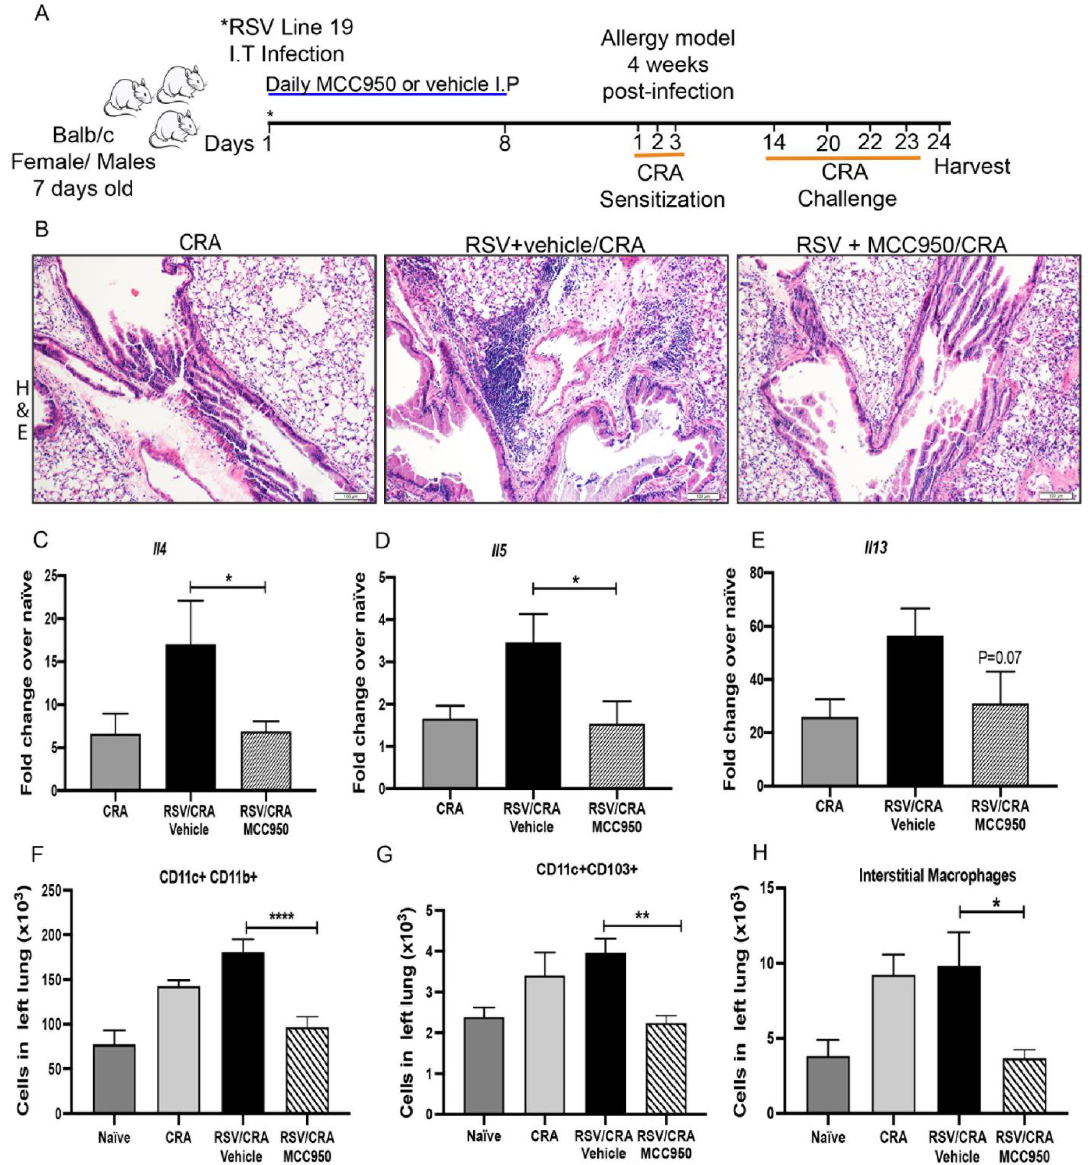
Figure 7. NLRP3-inflammasome inhibition during early-life RSV infection attenuated secondary allergic exacerbation. ( A ) 7-day old BALB/c neonate mice were infected with RSV, followed by cockroach allergy model (CRA). CRA was administered via intratracheal instillation into the lungs over 3 consecutive days, starting at 4-weeks post-infection, followed by 4 challenges 2 weeks later to elicit an allergic response as previously described. Naïve and CRA only treated mice were used as controls. ( B ) Lung histopathology in Hematoxylin and Eosin stain (H&E) showed strongly reduced lung inflammatory infiltration in the RSV+MCC950/CRA group compared with control RSV+ Vehicle/CRA. Scale bar = 100 µ m. ( C ) Il4 , ( D ) Il5 , ( E ) Il13 mRNA expression. Flow cytometry of the lung leukocytes ( F ) CD11c+CD11b+ antigen-presenting cells ( G ) CD11c+CD103+ antigen-presenting cells ( H ) Interstitial macrophages. Data represent the Mean ± SEM from 4 to 8 mice (experimental repeats 2). * p ≤ 0.05, ** p ≤ 0.01, **** p ≤